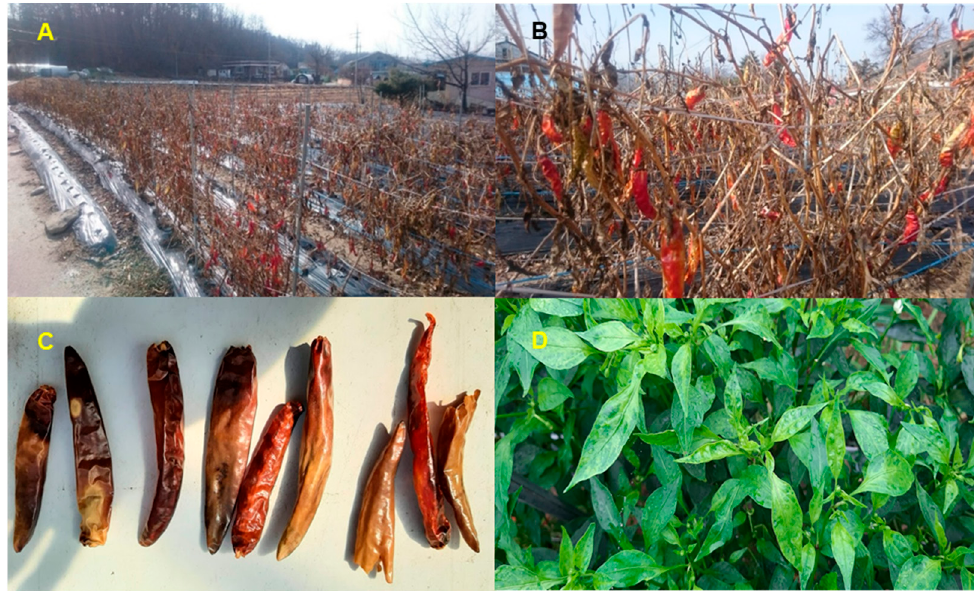
Figure 1 . Images of pepper fruits in field. Overwintering pepper plants in Region 63 ( A ) and Region 89 ( B ). ( C ) Dried pepper fruits derived from greenhouse in Region 48. ( D ) Pepper plants showing viral disease symptoms.